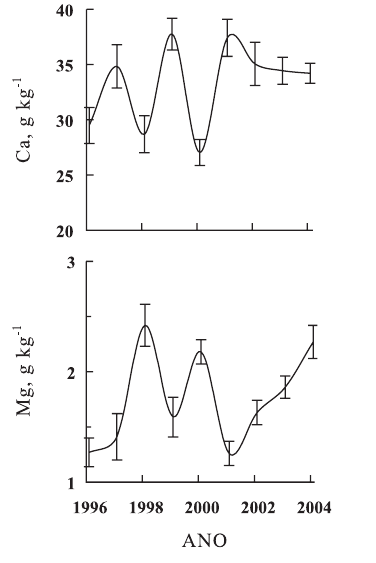
4. Teores médios e intervalos de confiança